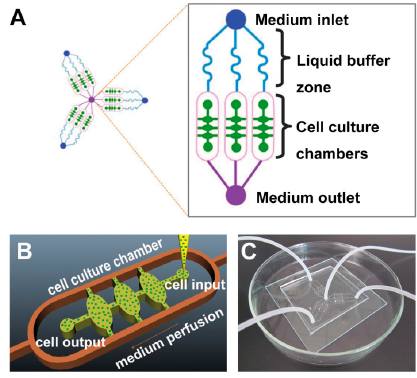
Figure 4. A microfluidic chip to investigate cancer cells invasion in 3D environment: ( A ) plan of the microchip; ( B ) an enlarged sketch of one of the cell culture chamber; ( C ) photograph of the device [82].